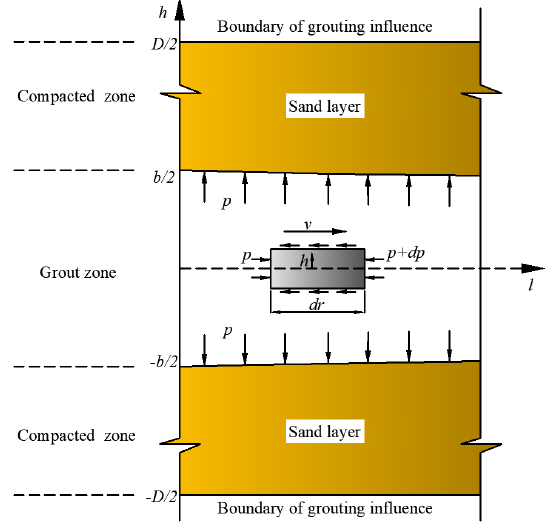
Figure 4. Force analysis of grout flow.